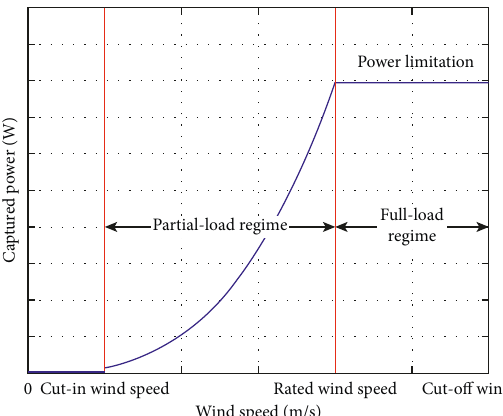
Figure 1: WECS operation modes in different wind speeds.